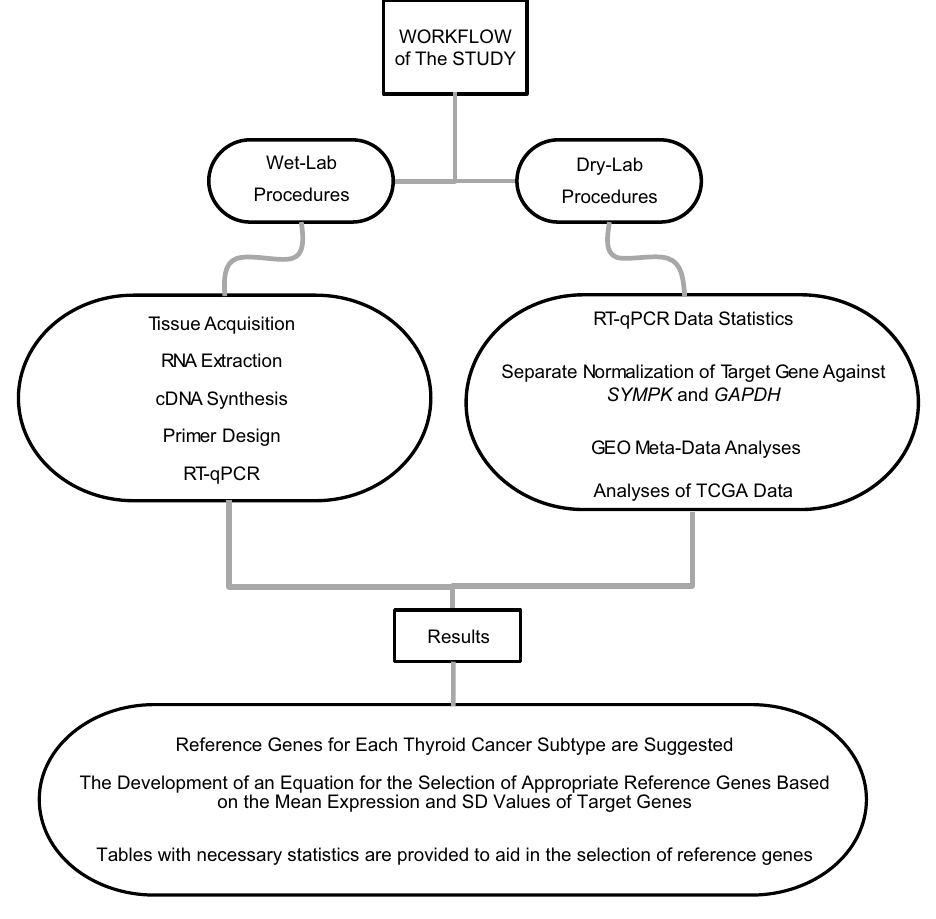
Figure 1. Workflow for performing bioinformatics analyses and laboratorybased